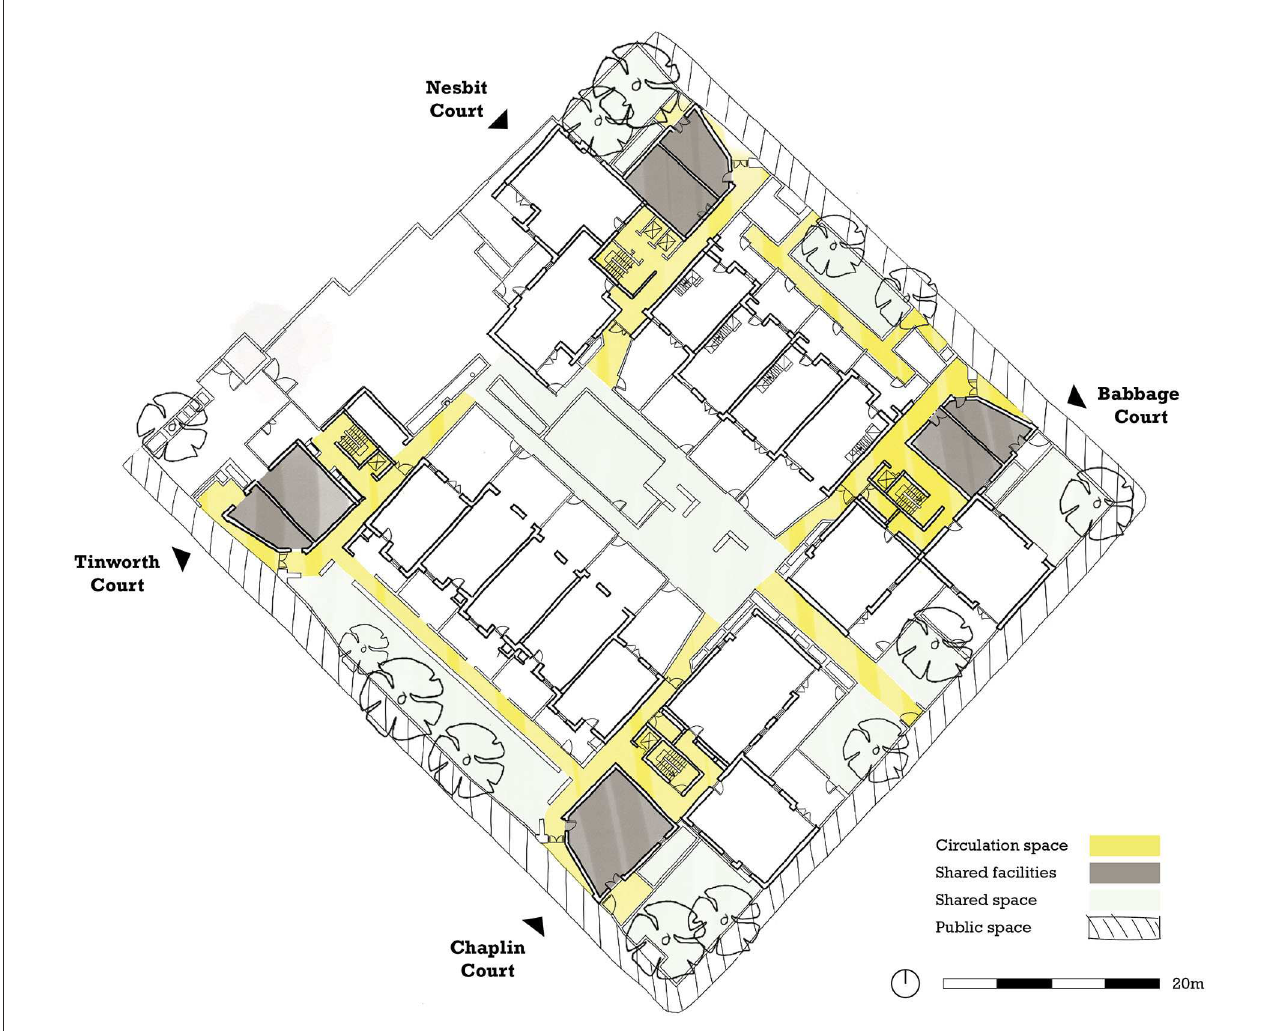
FIGURE8 Ground floor plan of Royal